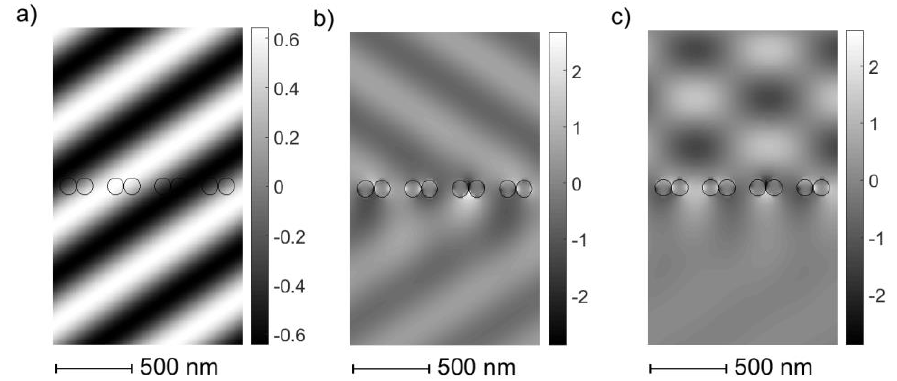
Fig. 3. The spatial distribution of the z - component of magnetic field for β ≈ 0.54 k 0 > β cr . The other parameters and notations are the same as in Fig.